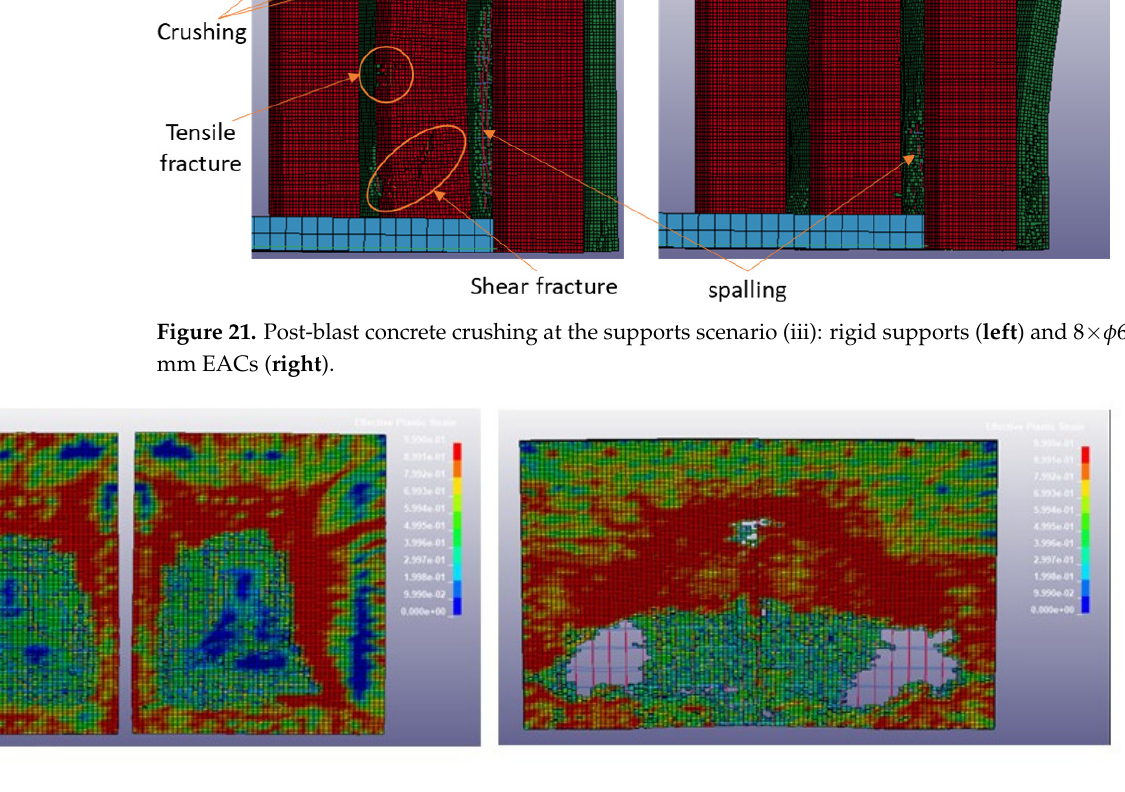
Figure 22. Post-blast spalling on the internal side of the façade